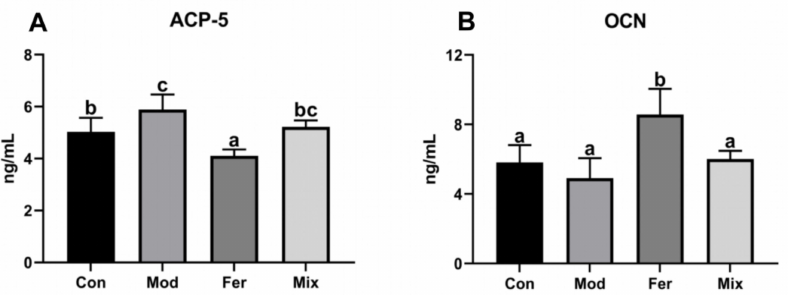
Figure 4. Serum levels of ACP-5 ( A ) and OCN ( B ). Serum of rats was collected at the time of execution, and the levels of ACP-5 and OCN were measured using ELISA kits. Values are expressed as mean ± SD (n = 6). With p < 0.05, values with various superscript letters differ